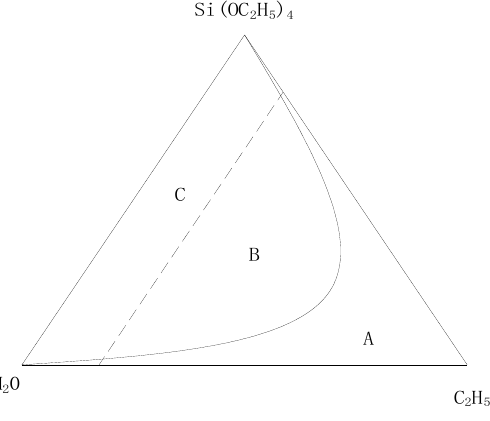
Figure 3. Hydrochloric acid promotes the ternary immiscible area expanding from A to B. During the reaction of hydrochloric acid with TEOS, the titration rate of hydrochloric acid also had a certain influence on the sol-gel.